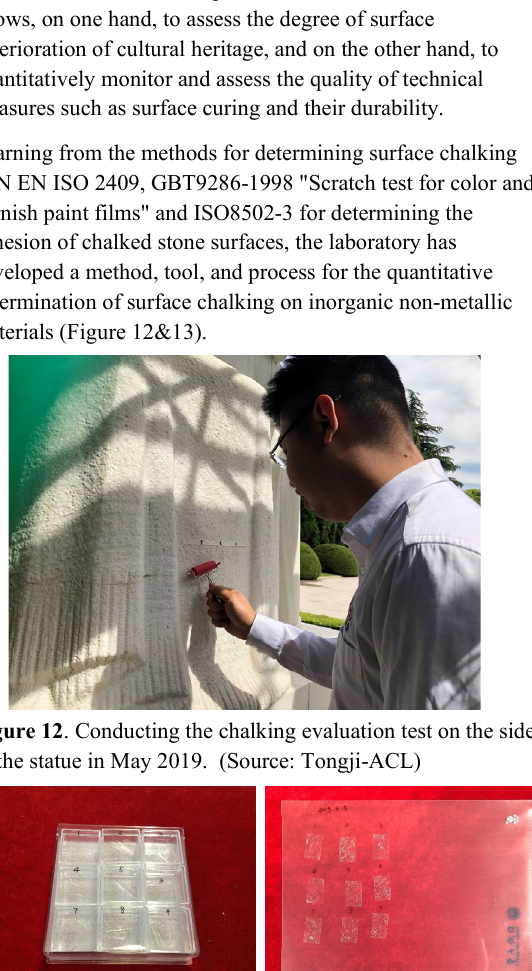
Figure 15 . Specimens to be analyzed (left) and the X-ray